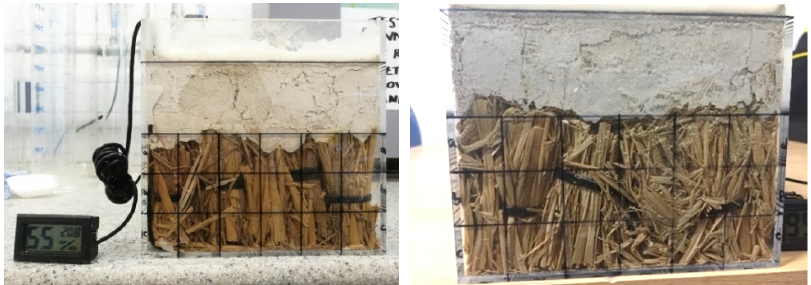
Figure 9. Specimen of wheat straw with perpendicular placing before the degradation research ( left ) and after 12 weeks in climatic chamber ( right ).